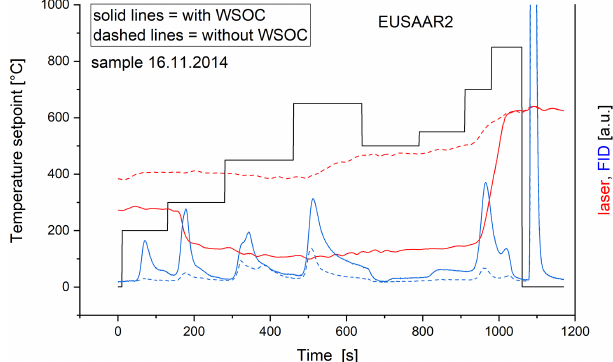
Figure 2. Typical thermogram of a sample with (solid lines) and without (dashed lines) WSOC. The transmission laser signal de- creases during the first three temperature levels for the unwashed sample (red solid line) but stays nearly constant for the washed sam- ple (red dashed line). The FID signals are lower for all temperature levels for the washed sample (blue dashed line) than for the un- washed sample (blue solid line). The black solid line represents the ideal progress of the sample